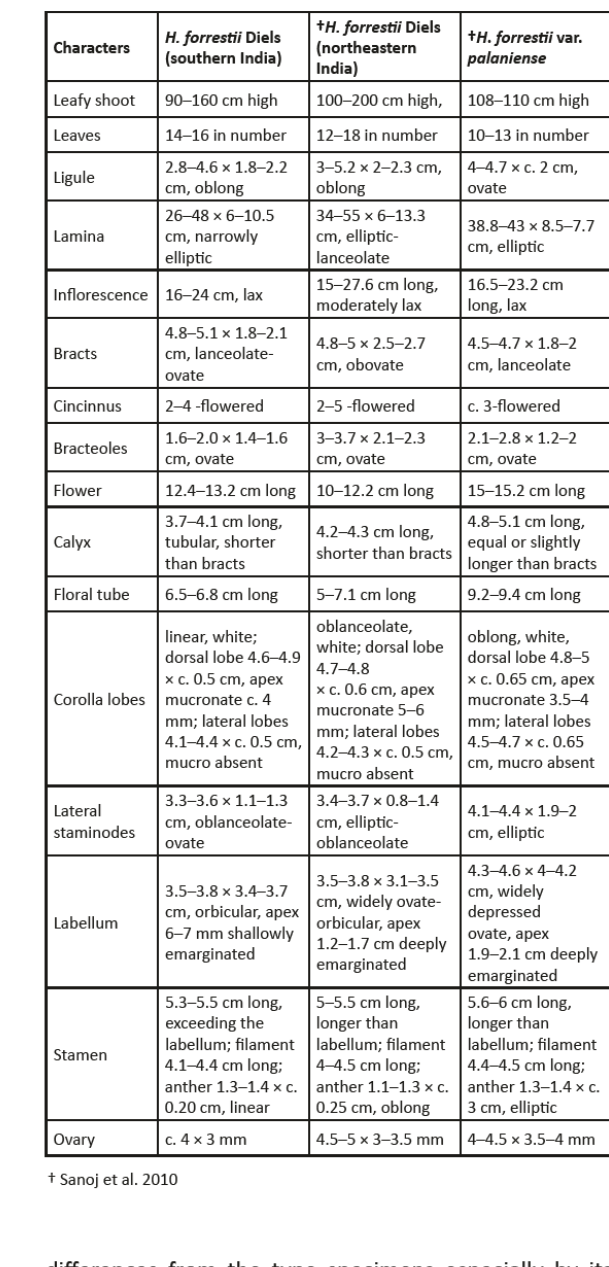
ffrom H. cernuum by fitts pfink finged and slender leaffy shoott, comparafively small lowers, sttrficttly 1–lowered bend sttamen and spurred tthecae. The green